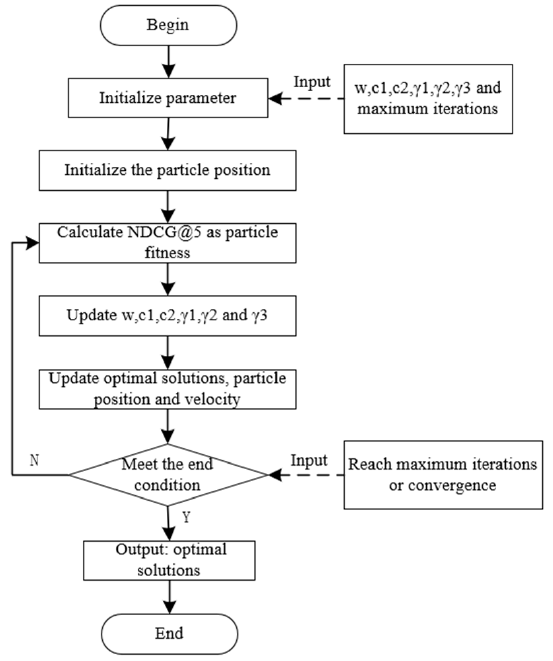
Figure 5. Flow chart of NDCG-IPSO.